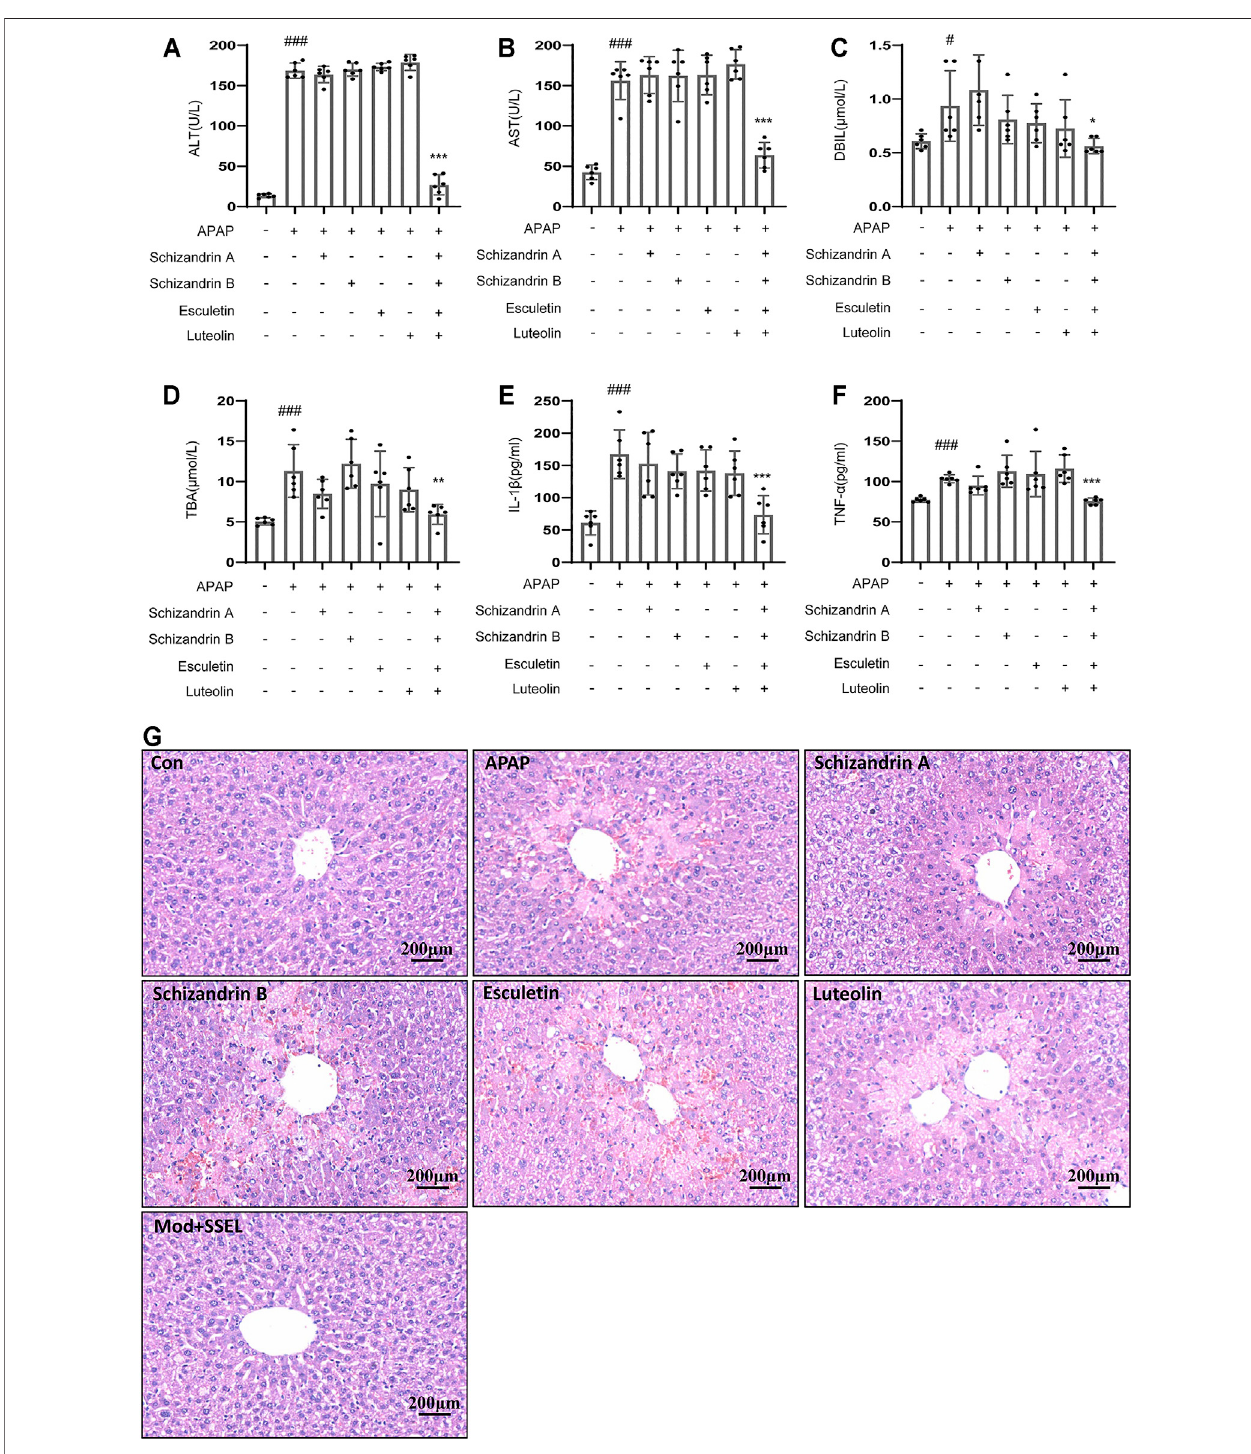
FIGURE 7 | Combination of LWWL active ingredients protect against APAP-induced acute liver injury in vivo . (A – G) Eight-week-old C57BL/6 male mice were administered with a vehicle, schisandrin A, schisandrin B, esculetin, and luteolin every day by gavage for 7 days. Further, 1 h after the fi nal gavage of schisandrin A, schisandrin B, esculetin and luteolin, mice in all groups (except the control group) were administered with APAP (300 mg/kg) by a single intraperitoneal injection. (A – D) Serum levels of ALT (A) , AST (B) , DBIL (C) and TBA (D) . (E,F) ELISA of IL-1 β (E) and TNF- α (F) . (G) H&E staining. The signi fi cance of the differences was analyzed using unpaired Student ’ s t-test: # p < 0.05, ## p < 0.01, ### p < 0.001 vs. control group; * p < 0.05, ** p < 0.01, *** p < 0.001 vs. the APAP group, NS, not signi fi cant.